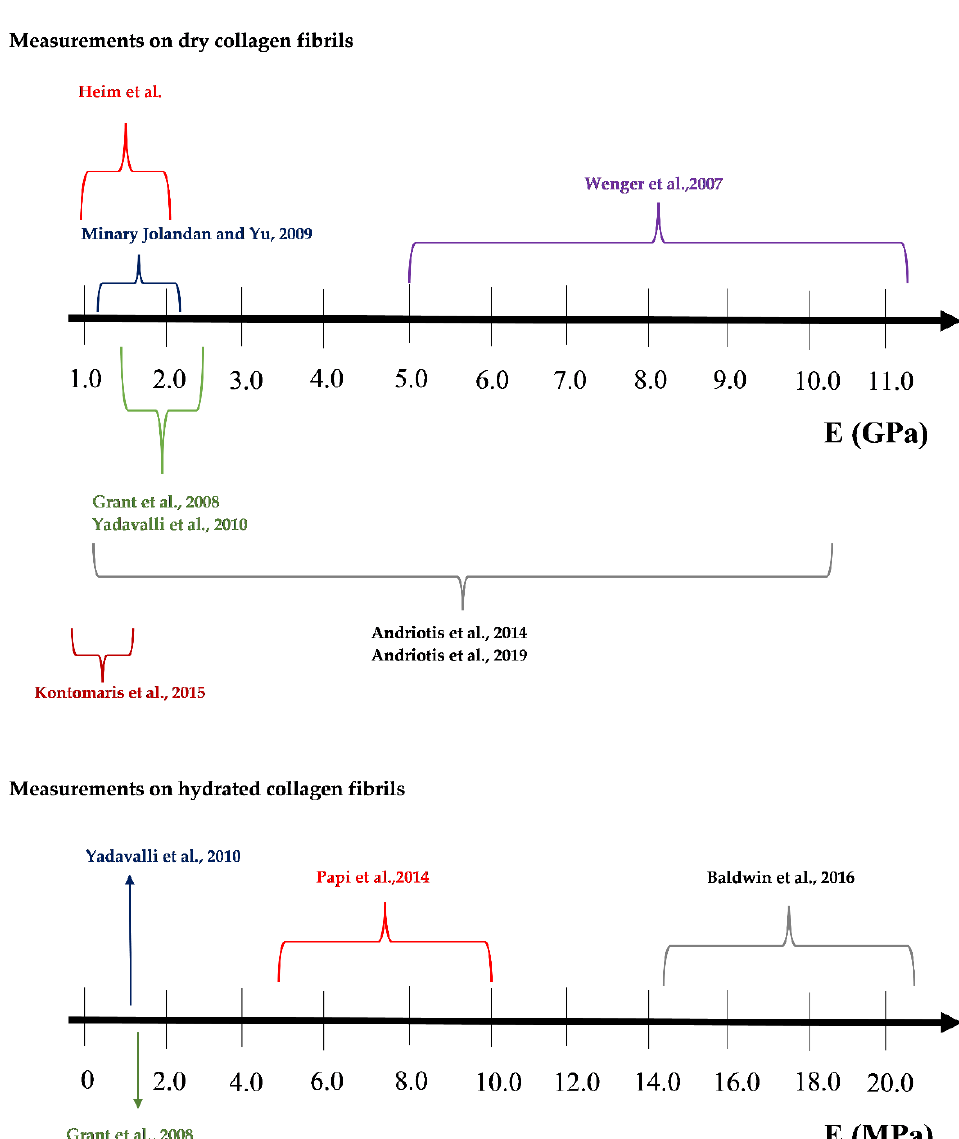
Figure 2. The range of Young’s modulus values in the literature